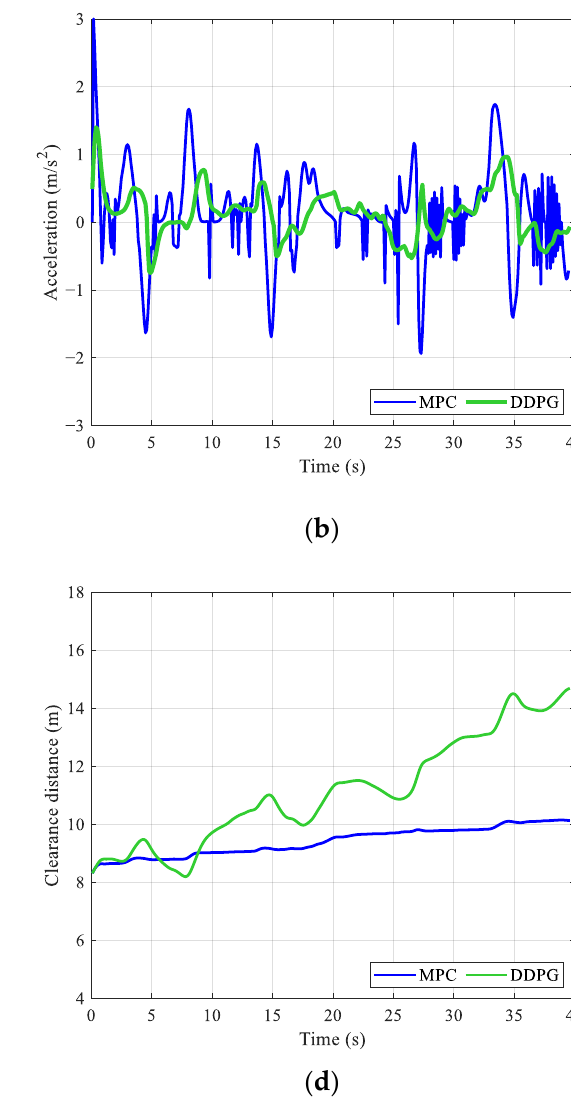
Figure 9. Speed control results for the AV with the leading vehicle No. 107 and a starting point at location 839 m on the sampled rough pavement: ( a ) speed, ( b ) acceleration, ( c ) jerk, and ( d ) clearance distance.